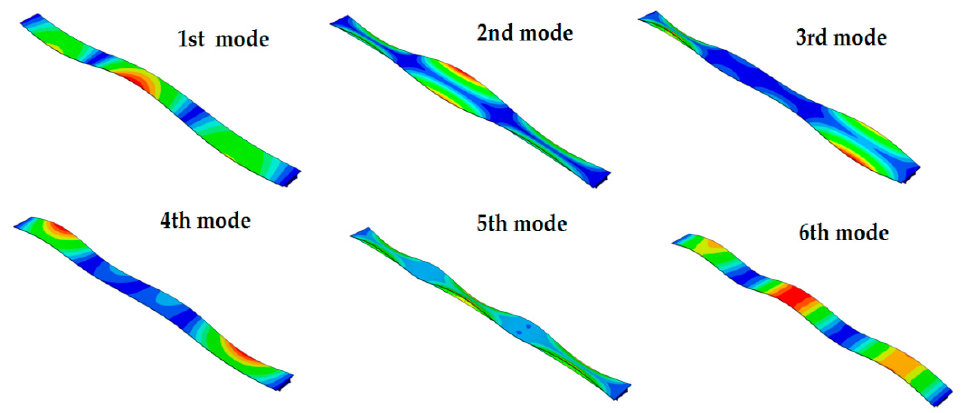
Figure 9. The mode shapes of the beam footbridge with the GFRP slab.